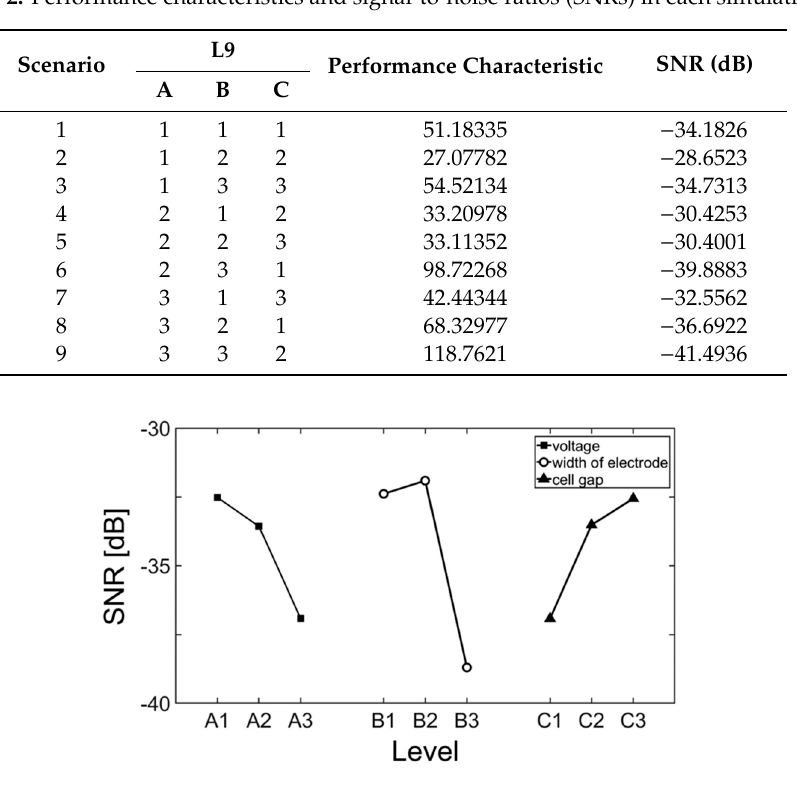
Table 2. Performance characteristics and signal-to-noise ratios (SNRs) in each simulation.